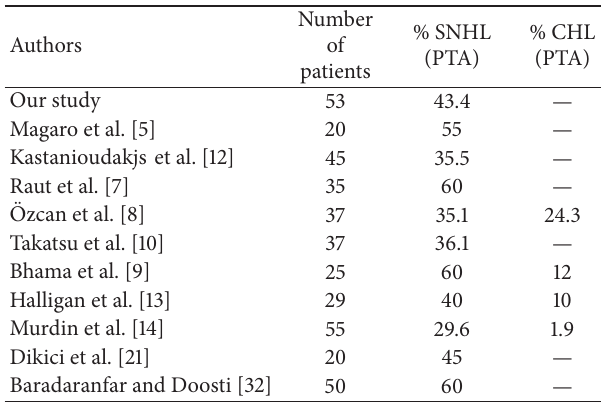
Table 1: Comparative analysis of results of SNHL and CHL as diagnosed using PTA in patients with RA, according to the reviewed sources. SNHL: sensorineural hearing loss; CHL: conductive hear- ing loss; PTA: pure tone audiometry; RA: rheumatoid